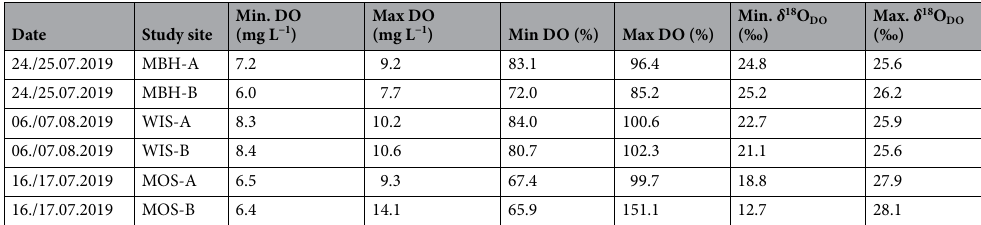
Table 3. Summary of measured minima and maxima of DO concentrations and saturations, and stable DO isotopes ( δ 18 O DO ) values at Mähringsbach (MBH), Wiesent (WIS) and Moosach (MOS) with respective upstream (A) and downstream (B)